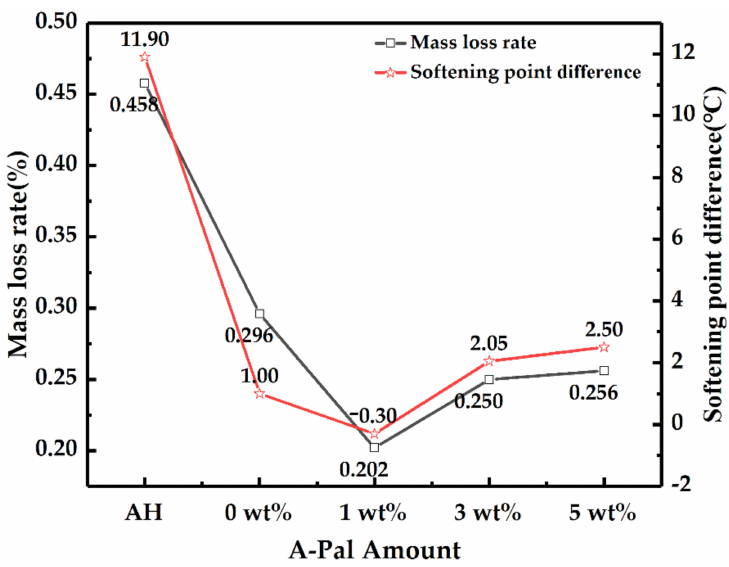
Figure 5. Mass loss rate and softening point of modified asphalt after thin film oven test (TFOT)